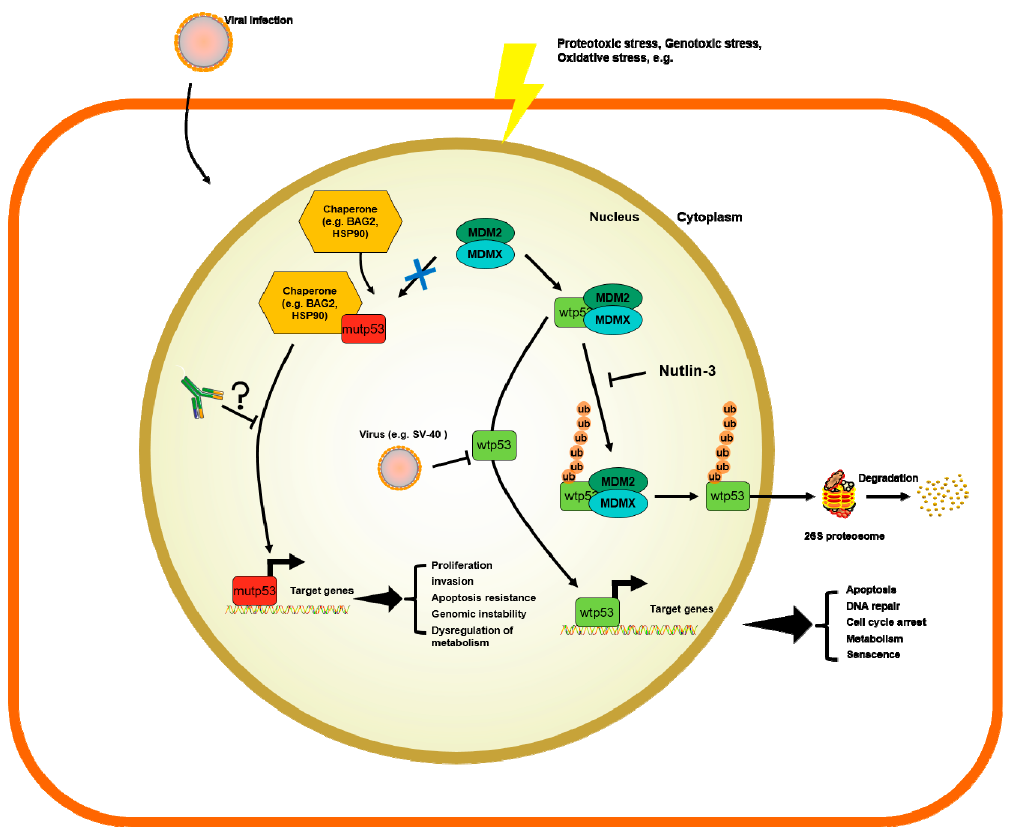
Figure 1. Mechanisms of regulation of wild-type p53 (p53-wt) and p53 mutants (p53-mut) and the potential role of p53 antibodies (p53-Abs).